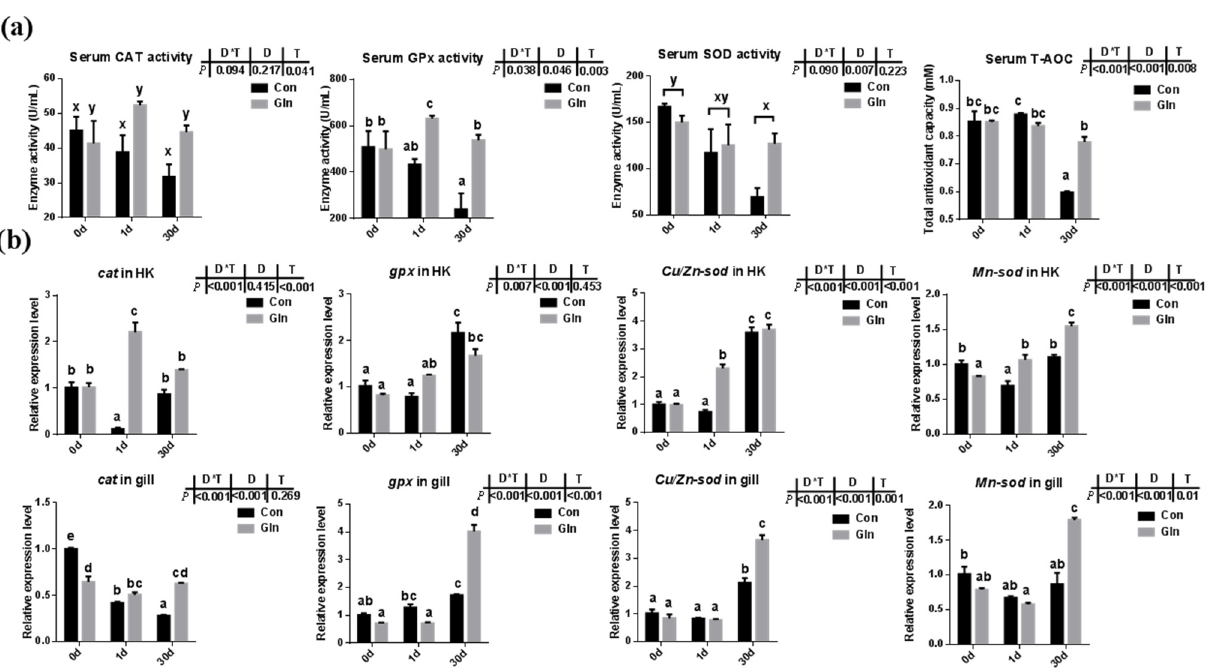
Figure 2. The effects of dietary glutamine on the antioxidant system of yellow catfish during F. columnare infection. ( a ) The enzyme activities of catalase (CAT), glutathione peroxidase (GPx), superoxide dismutase (SOD) along with total antioxidant capacity in serum of yellow catfish in both control group (Con) and glutamine supplementation group (Gln) at 0 d, 1 d and 30 d after F. columnare infection ( n = 6). ( b ) The relative mRNA expression level of cat , gpx , Cu/Zn-sod and Mn-sod in head kidney and gill of yellow catfish in all treatments ( n = 3). All data was analyzed with two-way analysis of variance (ANOVA) and data are means ± SD. When significant D*T were observed ( p < 0.05), data were analyzed by one-way ANOVA followed by Tukey’s multiple